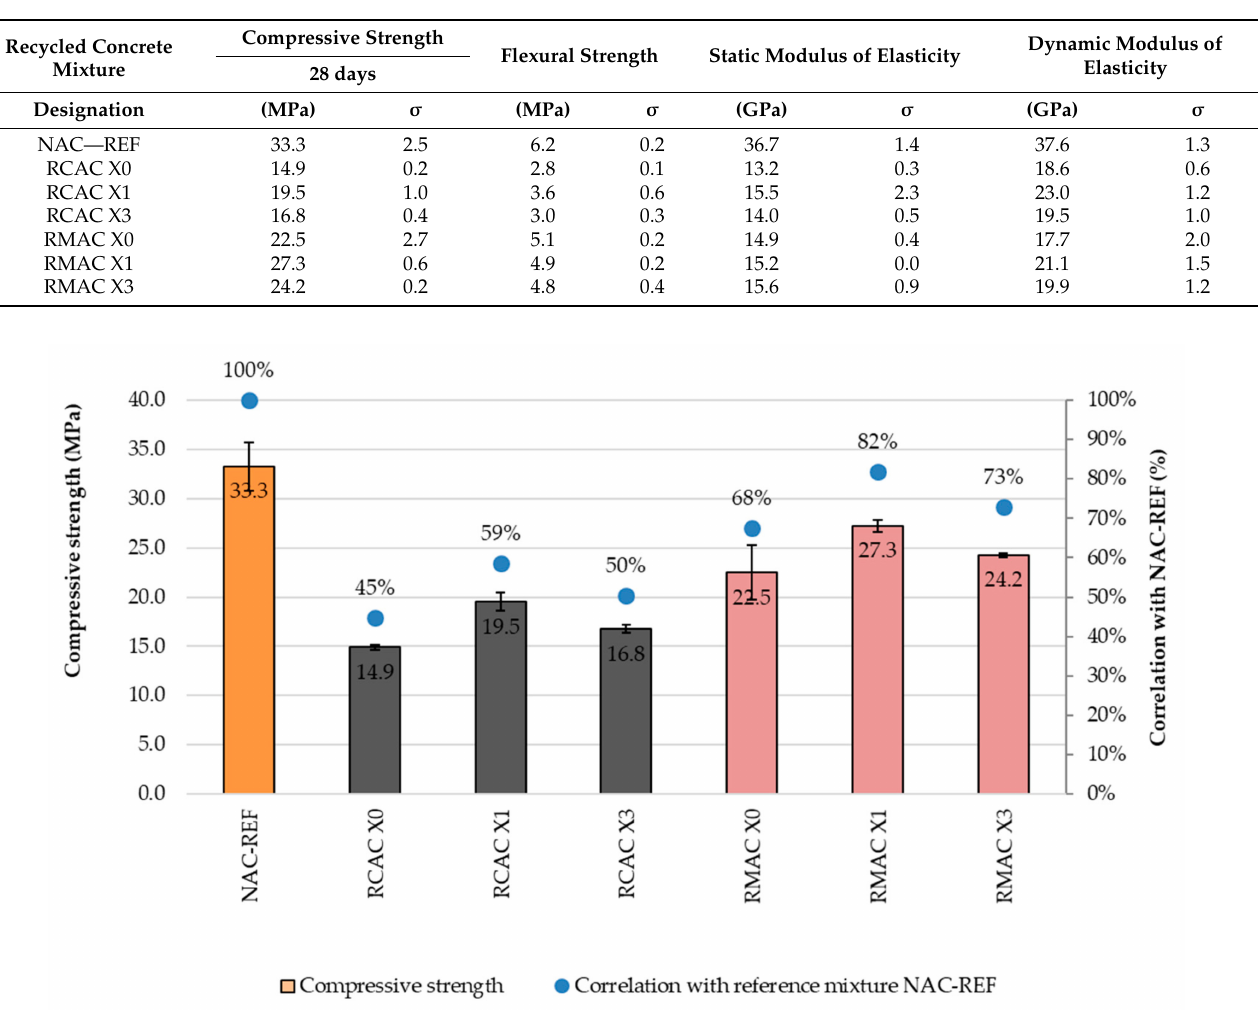
Table 5. Average values of results of mechanical properties of concrete, including standard deviation.